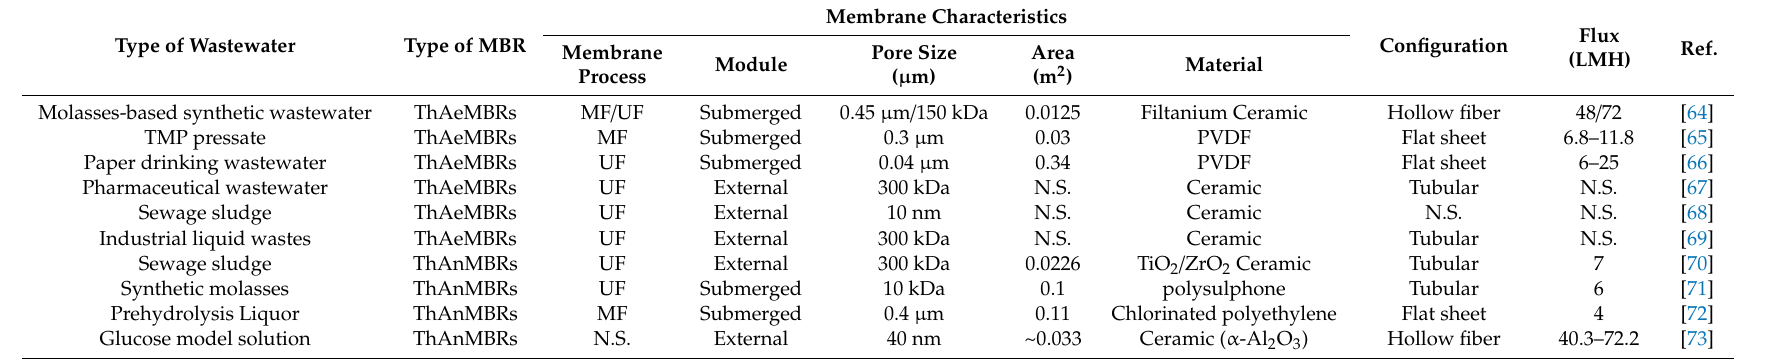
Table 2. Membrane properties of di ff erent